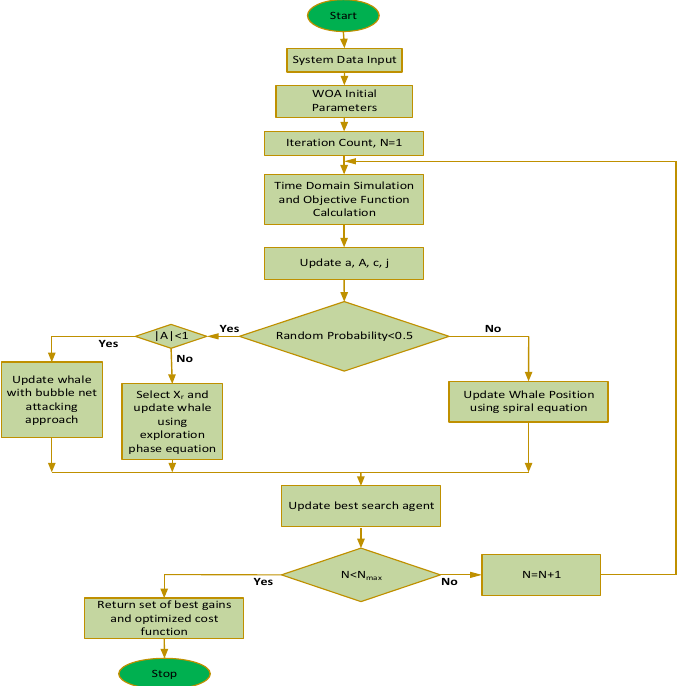
Figure 4. WOA flowchart for controller parameter optimization. Several measurements were optimized with WOA, and are visualized along with the implementation of a fractional-order supercapacitor using the FOMCON tool in Figure 5.